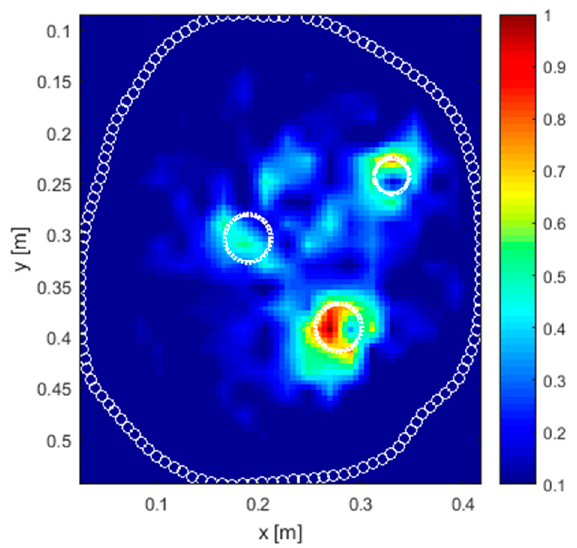
Figure 16. Tomographic reconstruction of the real tree scenario. The dashed white circles indicate the actual position of the anomalies. The circles in white solid line along the trunk perimeter represent the positions of the measurement points.